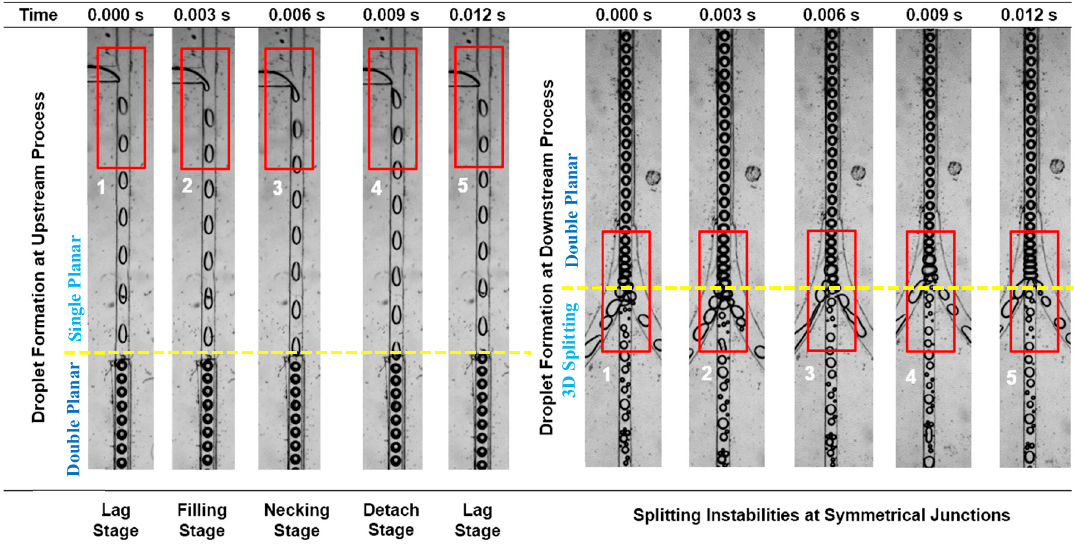
Figure 5. Evolution of droplet breakup and fission process at the upstream T-Junction and downstream of symmetrical splitting junctions (for system: Q c = 2 mL/h; Q d = 1 mL/h).